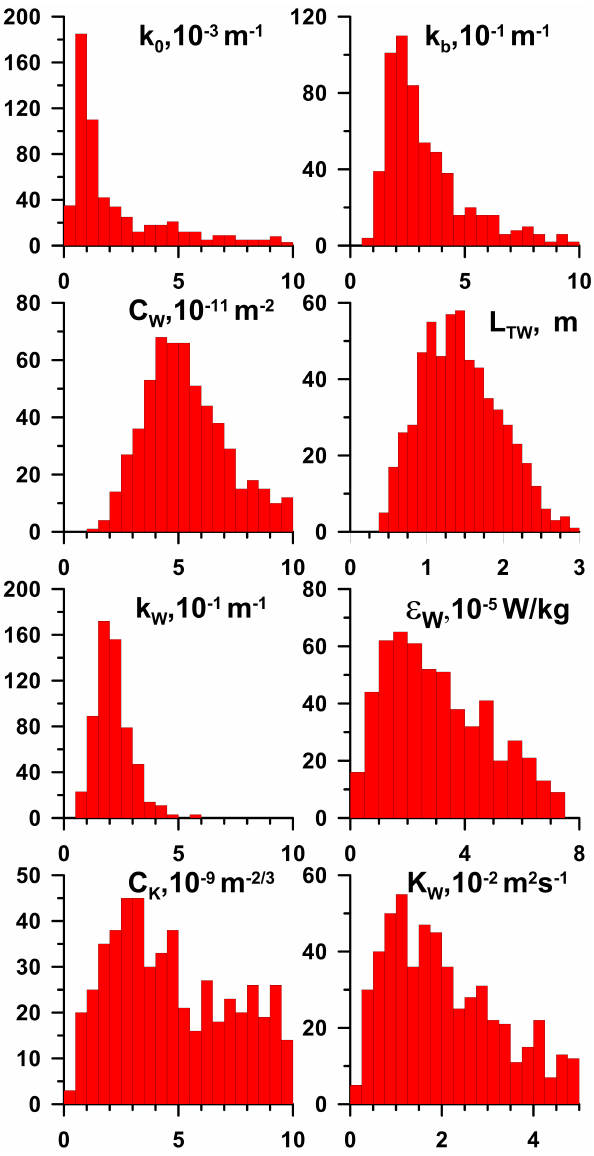
Fig. 2. Histograms of anisotropic and isotropic spectral parame- ters and turbulent characteristics in September–November 2004 at 40km altitude.